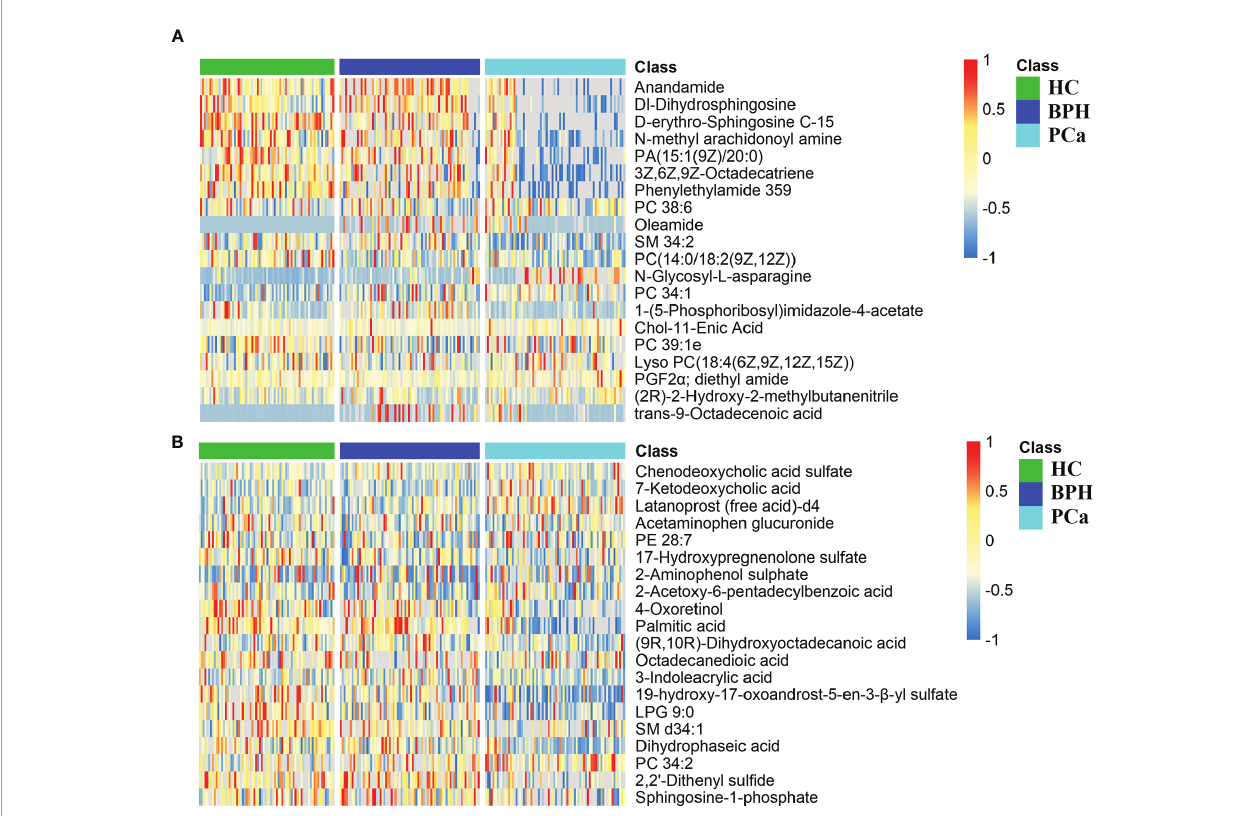
FIGURE 4 | Differential metabolite heat maps in positive (A) and negative (B) modes. The columns represent samples, the rows represent metabolites, and the relative content of the metabolites is displayed by color. The heat map shows differential metabolites among HC, BPH, and PCa groups. HC, healthy control; BPH, benign prostatic hyperplasia; PCa, prostate cancer.